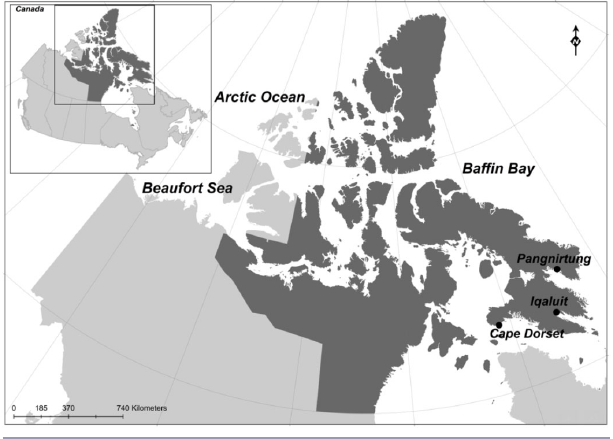
Fig. 1 .Map of study region: Cape Dorset and Pangnirtung, Nunavut, are identified, as well as Iqaluit, the capital. Inset map shows study region relative to